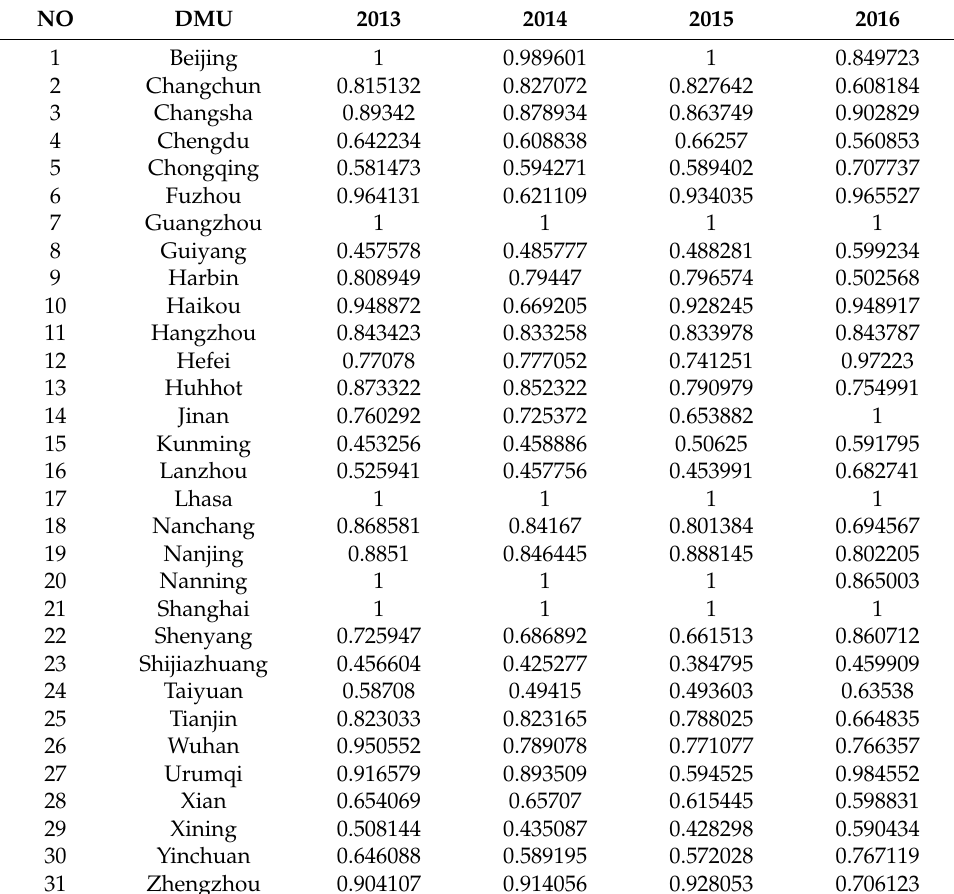
Table 2. Overall efficiency scores for each city from